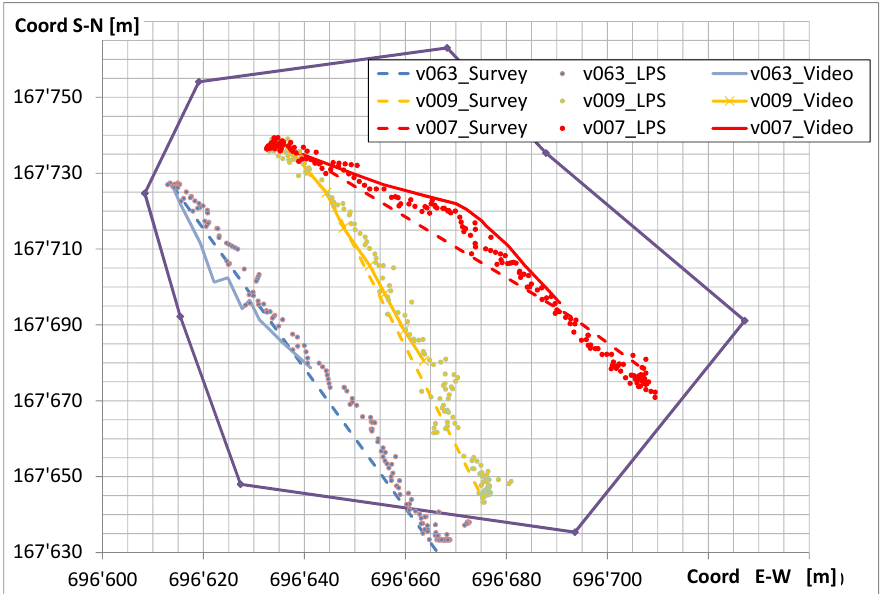
Figure 10. Comparison of the different trajectory measuring methods of tests 7, 9 and 63 projected onto a horizontal basis projected according to CH1903 coordinate system: dashed lines represent straight connections between start and end points, continuous lines show paths obtained from video analysis and dots show point clouds from the LPS